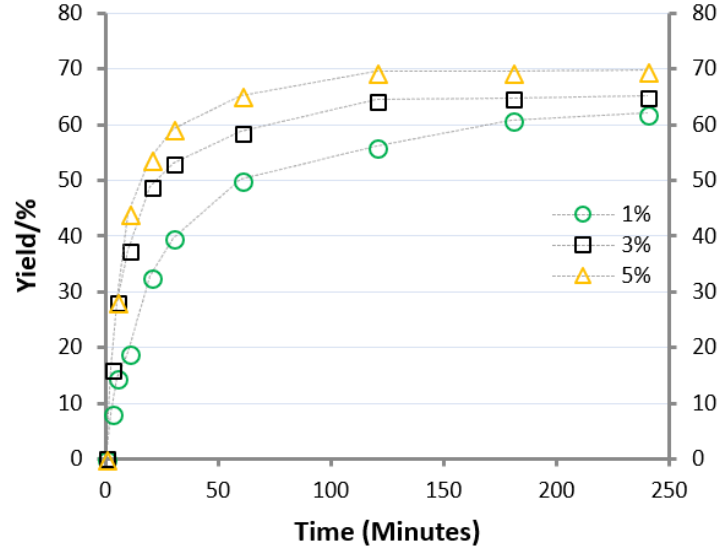
Figure 4. Direct esterification of Levulinic Acid (LA) at different catalyst concentrations. Reaction conditions: molar ratio ethanol:LA = 1; AlCl 3 ∙6H 2 O from 1 to 5%mol, temperature = 348 K, time = 8 h.